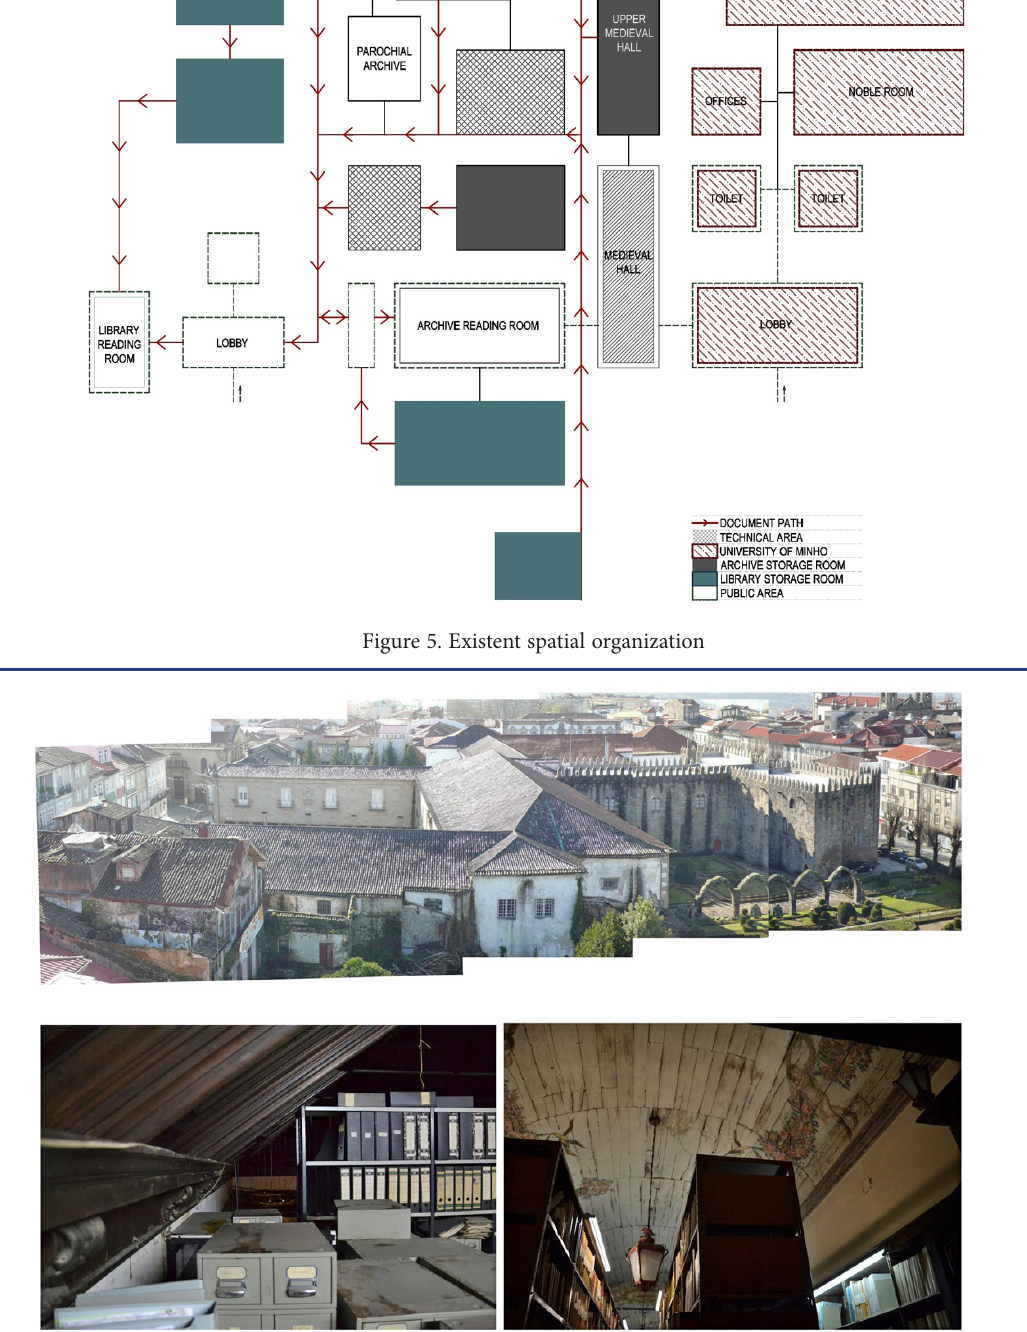
Figure 6. Current state of the Largo do Paço